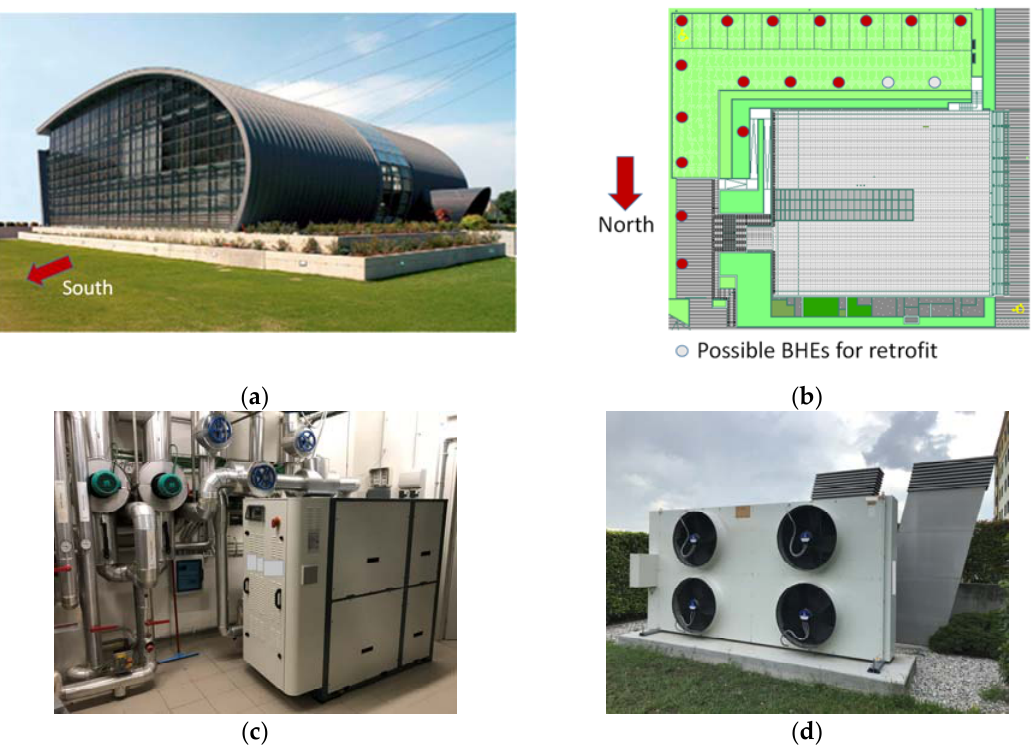
Figure 2. Case study: ( a ) building, ( b ) layout of the installed boreholes, ( c ) new heat pump, ( d ) air ‐ condenser.